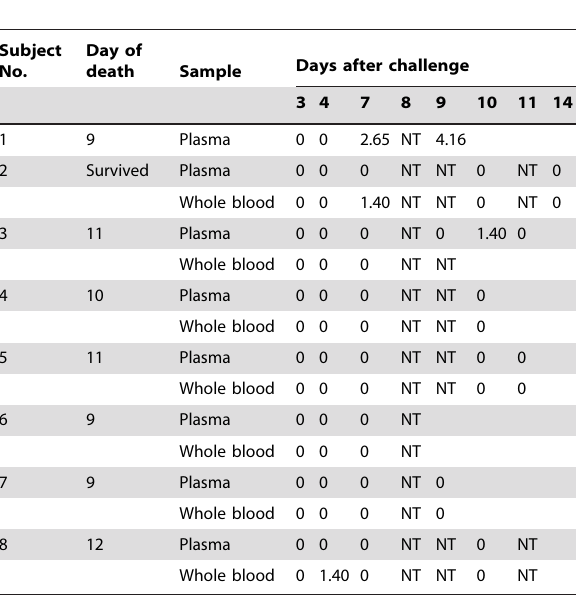
Table 2. Viral load in African green monkeys after Nipah virus challenge.